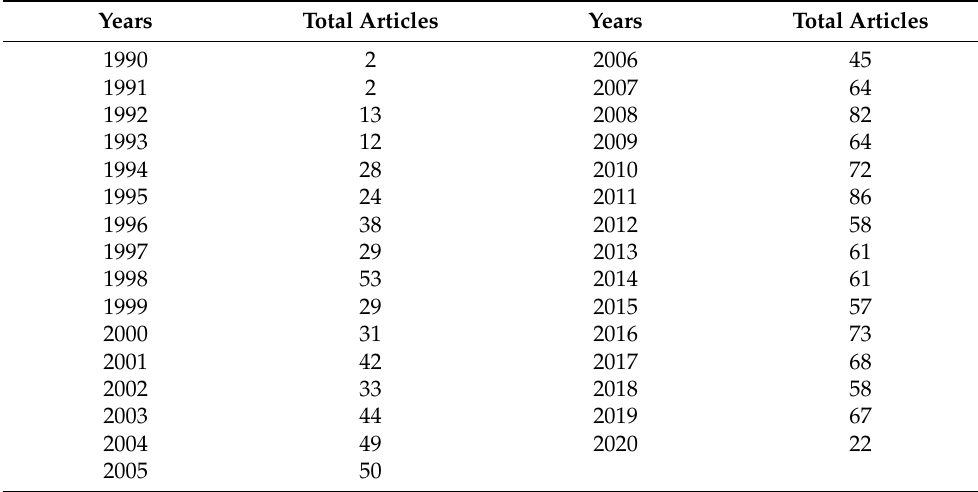
Table 2. Publications per year of the source paper by ABC